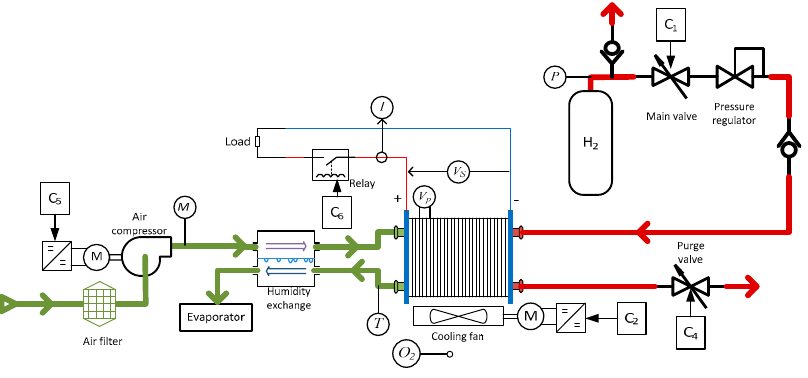
Figure 2. Block diagram of the Nexa fuel cell balance of a plant.